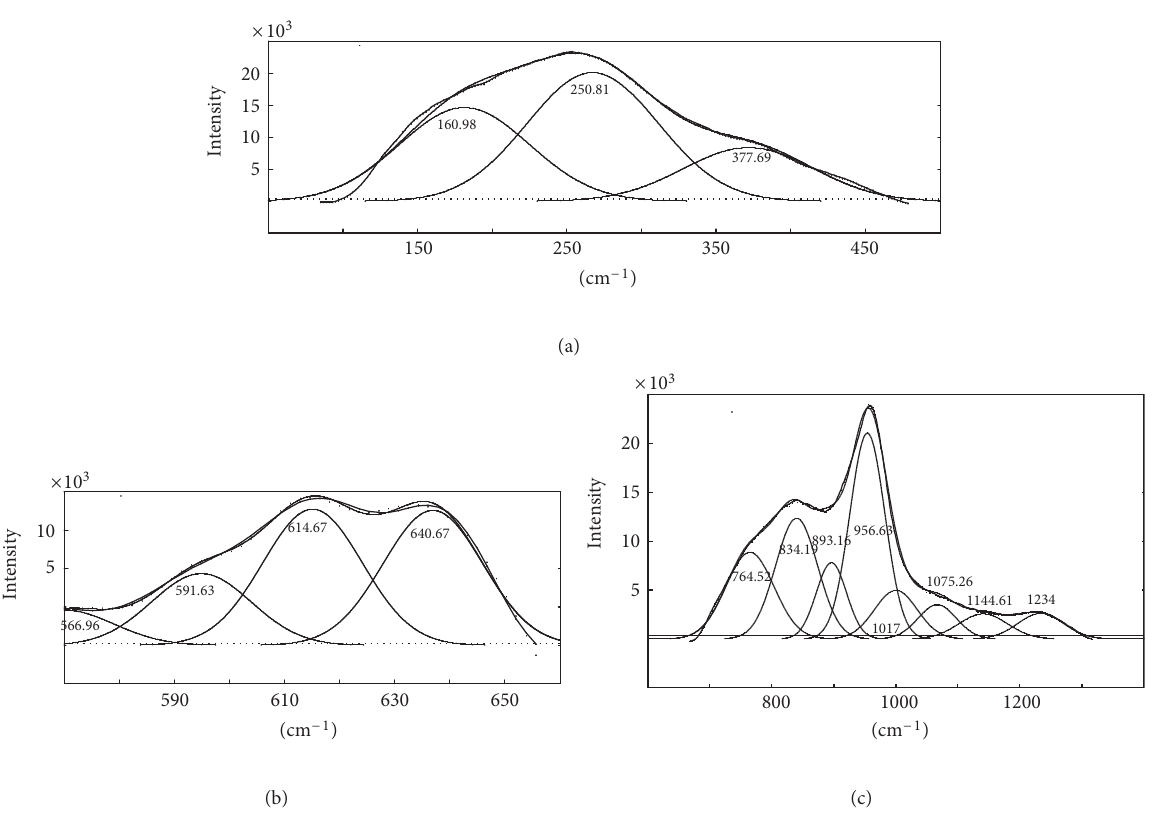
F 5: Deconvolution of the LiW-40 Raman spectrum in three frequency regions: (a) low, (b) medium, and (c)